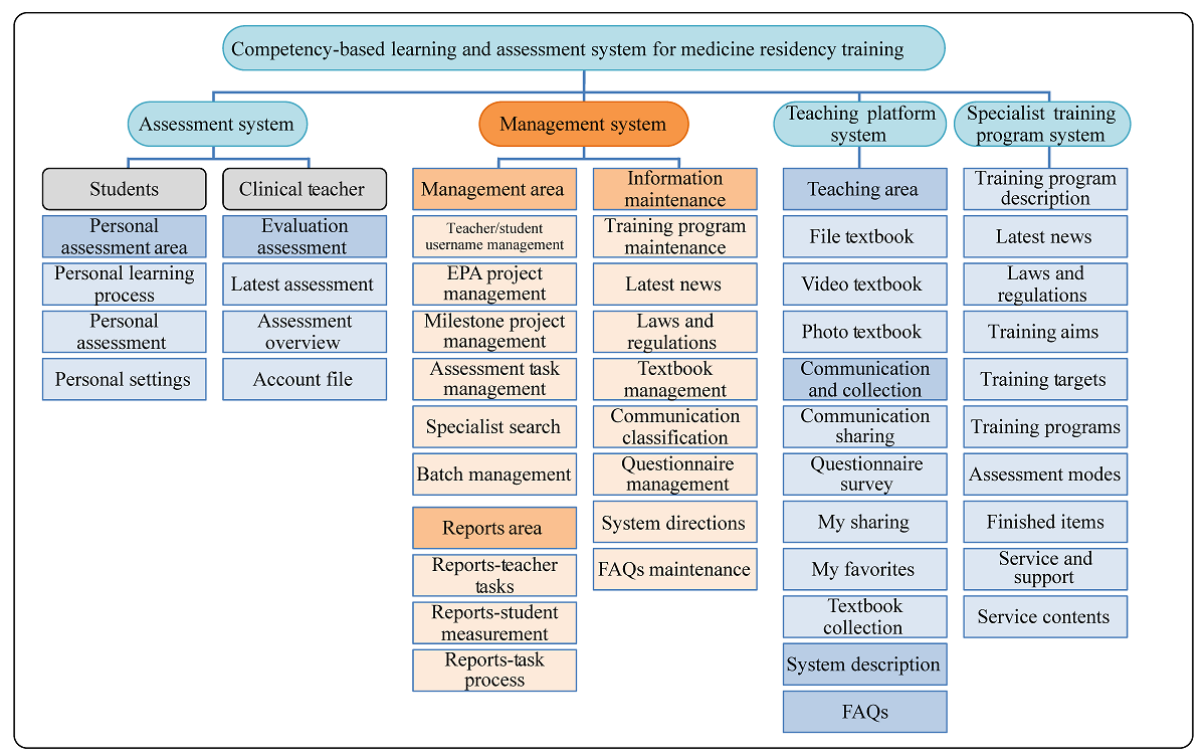
Figure 1. System